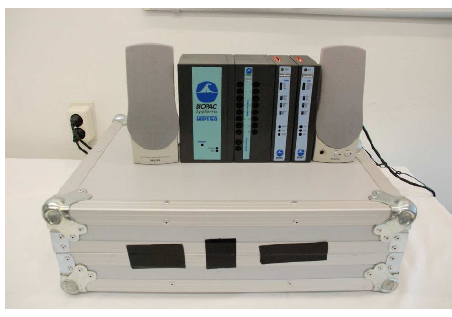
Figure 2. The technical box embodiment using the Biopac MP-150 system.